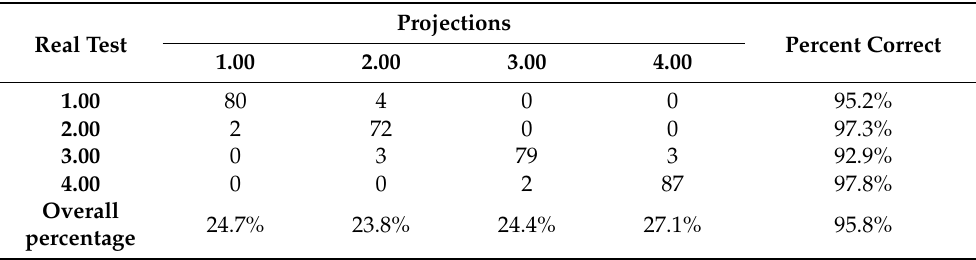
Figure 8. QUEST-based lower limb motion comfort level analysis and determination model. Table 10. Prediction accuracy of QUEST-based lower extremity motion comfort level analysis and determination